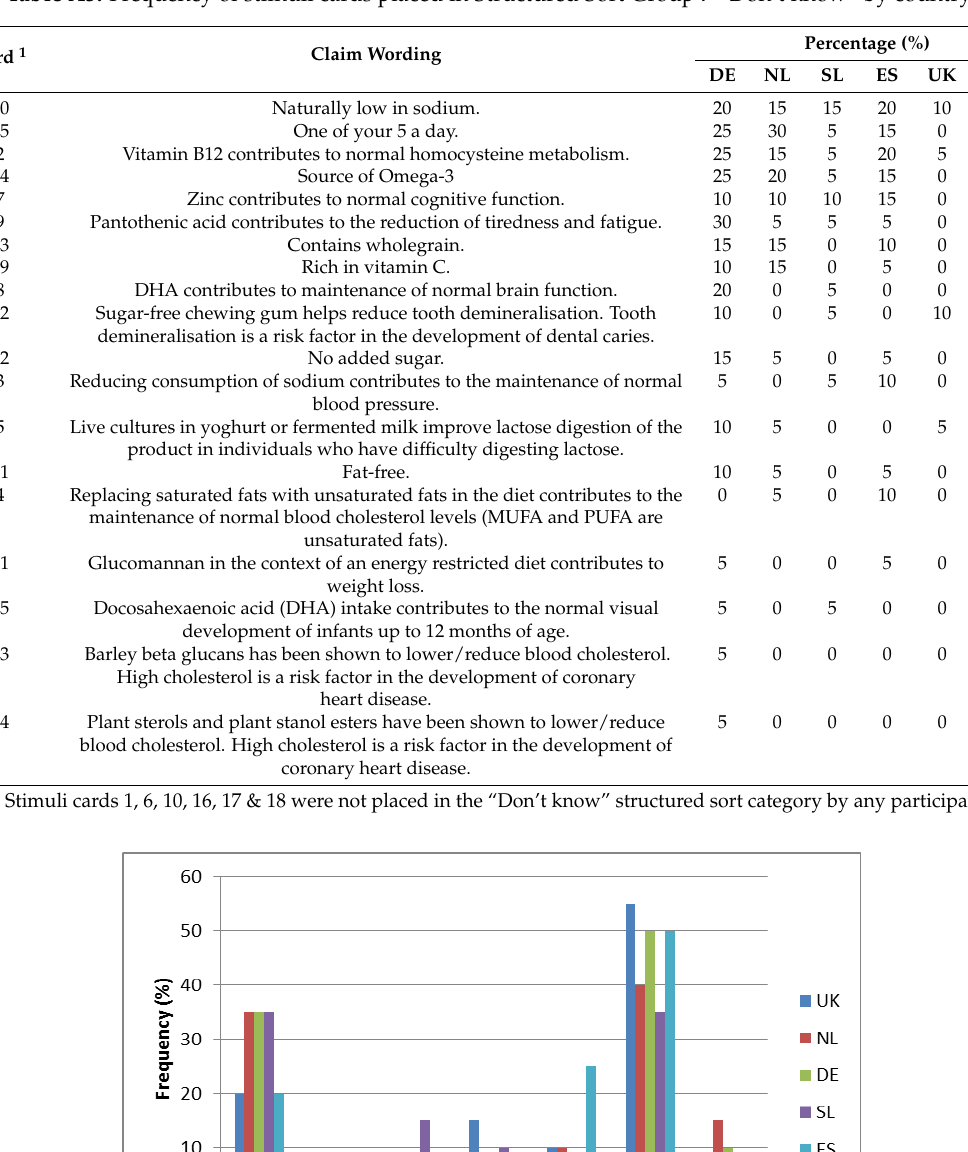
Figure A2. Frequency of structured sort placement of nutrition claims per country—‘Naturally low in sodium’ (Card 20).